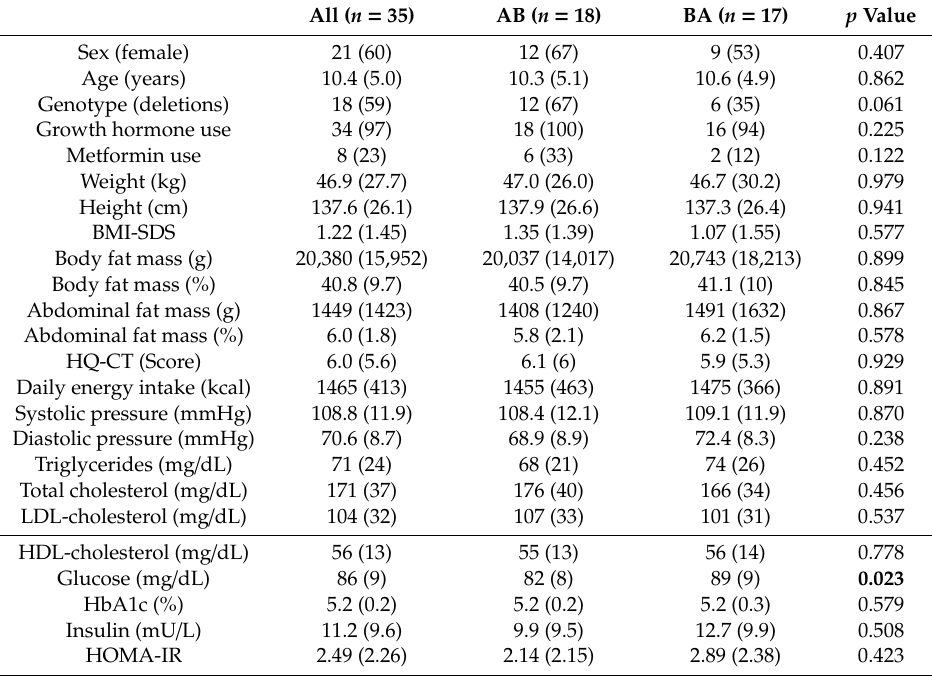
Figure 1. Flow chart of the study participants. The flow chart of participants throughout the study is shown. A corresponds to placebo treatment and B to Bifidobacterium animalis subsp. lactis strain BPL1 probiotic treatment. AB, treatment sequence placebo-BPL1; BA, treatment sequence BPL1-placebo. Table 1. Basal demographic and physiologic characteristics of